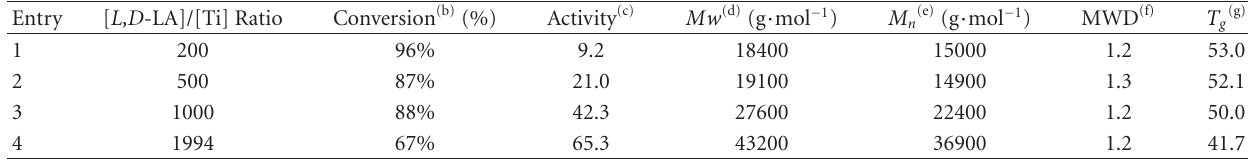
Table 1: Thermally induced polymerisation of L , D -LA using complex ( 1 ) (a) .